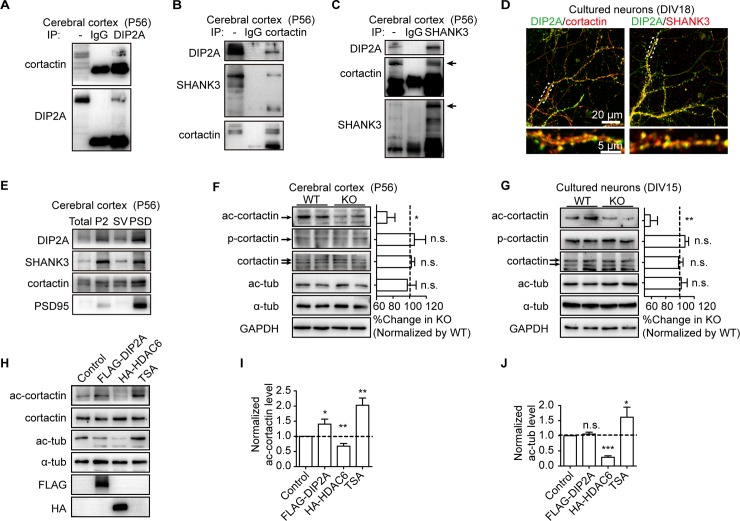
DIP2A interacts with cortactin and modulates cortactin acetylation (ac-cortactin).(A) Interaction between endogenous DIP2A and cortactin from murine brain lysates. (B and C) Interaction between endogenous DIP2A, cortactin, and SHANK3 from murine brain lysates. (D) Representative image showing colocalization of DIP2A (green) and cortactin or SHANK3 (red) in cultured neurons. (E) Western blot showing DIP2A and cortactin, and SHANK3 in the cortical PSD composition (lane 4). Total, total homogenate; P2, crude synaptosomes; SV, crude synaptic vesicle fraction. (F) Western blot and bar graph showing Dip2a deletion reduced ac-cortactin without altering levels of total cortactin and phosphorylated cortactin (p-cortactin) (P56, males; n = 4 mice per genotype; data from 3 independent experiments). Levels of ac-cortactin and tubulin (ac-tub) were normalized to total cortactin and α-tubulin, respectively. The ratio in WT mice was set to 100% (ac-cortactin, t10 = 2.320, *P = 0.0428; p-cortactin, t10 = 0.8637, n.s. P = 0.4080; cortactin, t10 = 1.712, n.s. P = 0.1177; ac-tub, t10 = 0.1943, n.s. P = 0.8498). (G) Dip2a deletion reduced ac-cortactin without affecting total or p-cortactin levels in cultured cortical neurons (DIV15) (data from 3 independent experiments, approximately 5 × 106 cells per experiment; ac-cortactin, t10 = 3.258, **P = 0.0086; p-cortactin, t10 = 0.1551, n.s. P = 0.8798; cortactin, t10 = 0.4124, n.s. P = 0.6888; ac-tub, t10 = 0.1507, n.s. P = 0.8832). (H) Western blot showing overexpressed DIP2A in cultured cells with elevated ac-cortactin level. (I and J) Normalized grayscale value in (H) (data from 3 independent experiments and presented as mean ± SEM; one-way ANOVA; I, F3,20 = 19.13, post hoc LSD, *P = 0.0199, **P = 0.0020 and 0.0016, respectively; J, F3,20 = 17.76, post hoc LSD, n.s. P = 0.3227, ***P < 0.0001, *P = 0.0379). The underlying data for this figure can be found in S1 Data. ac-cortactin, cortactin acetylation; DIP2A, disconnected-interacting protein homolog 2 A; DIV, day in vitro; FLAG, FLAG tag with the sequence DYKDDDDK; GAPDH, glyceraldehyde 3-phosphate dehydrogenase; HA, HA-tag (YPYDVPDYA); HDAC6, histone deacetylase 6; IgG, immunoglobulin G; IP, immunoprecipitation; KO, knockout; LSD, least significant difference; n.s., no significance; p-cortactin, phosphorylated cortactin; PSD, postsynaptic density; P2, crude synaptosomes; SHANK3, SH3 and multiple ankyrin repeat domains 3; SV, crude synaptic vesicle fraction; TSA, trichostatin A; tub, tubulin; WT, wild-type.